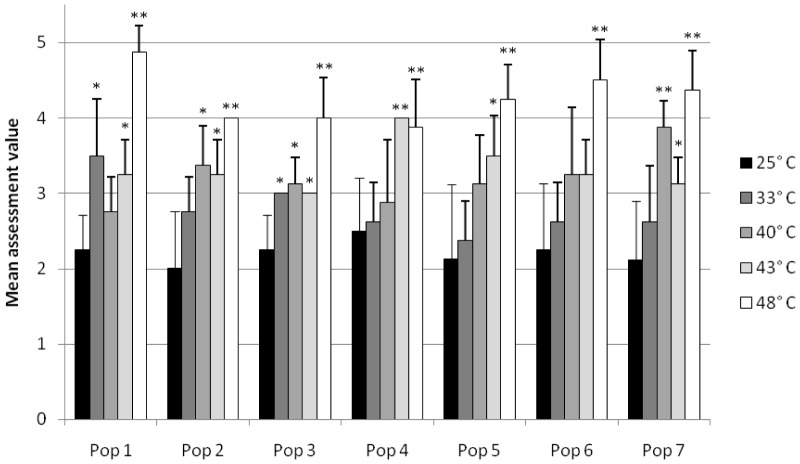
The condition of the digestive cells of the hepatopancreas.Mean assessment values for each population at elevated temperature. Shown are means and SD; n = 8. Asterisks show significant differences of the respective exposure groups compared to the control at 25°C after Bonferroni correction: 0.0025<P≤0.0125: (*) and 0.00025<P≤0.0025 (**).